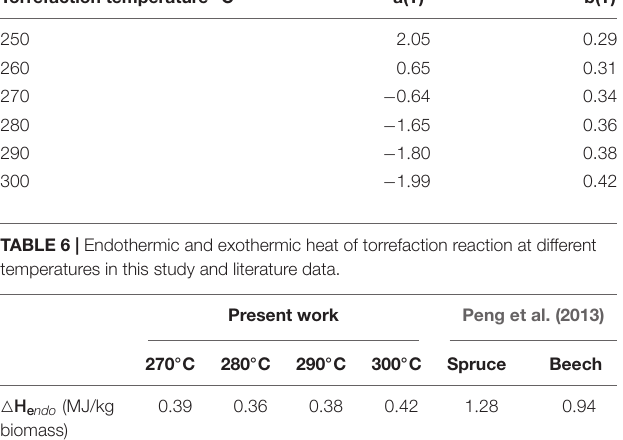
TABLE 5 | Linear correlations between torrefaction reaction heat and weight loss at different temperatures. Torrefaction temperature ◦ C